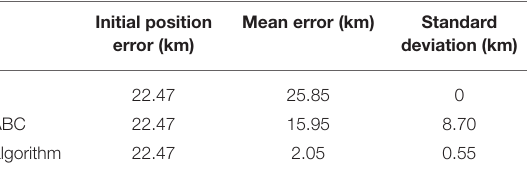
TABLE 5 | Statistical results of the matching errors.